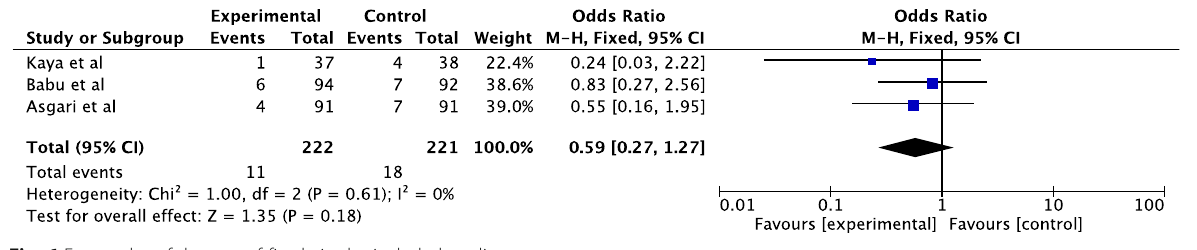
Fig. 6 Forest plot of the rate of fistula in the included studies